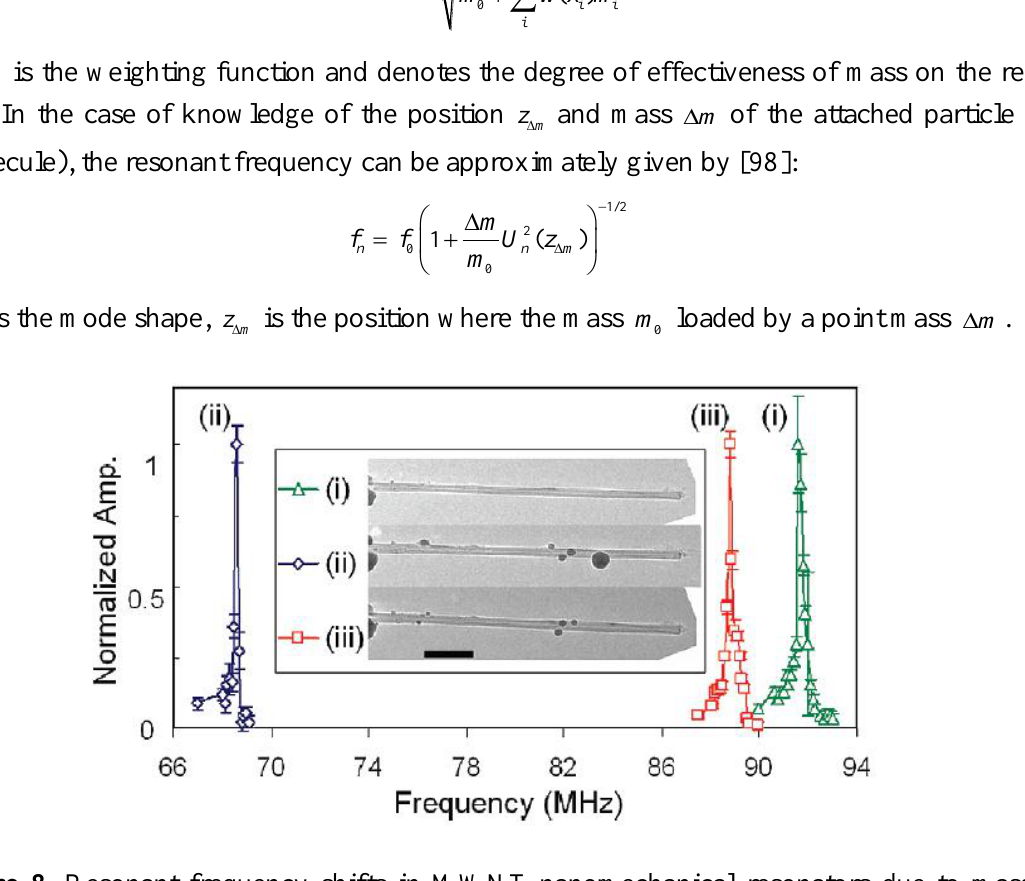
Figure 8. Resonant frequency shifts in MWNT nanomechanical resonators due to mass migration. Reused with permission from [97], Copyright 2009, American Chemical